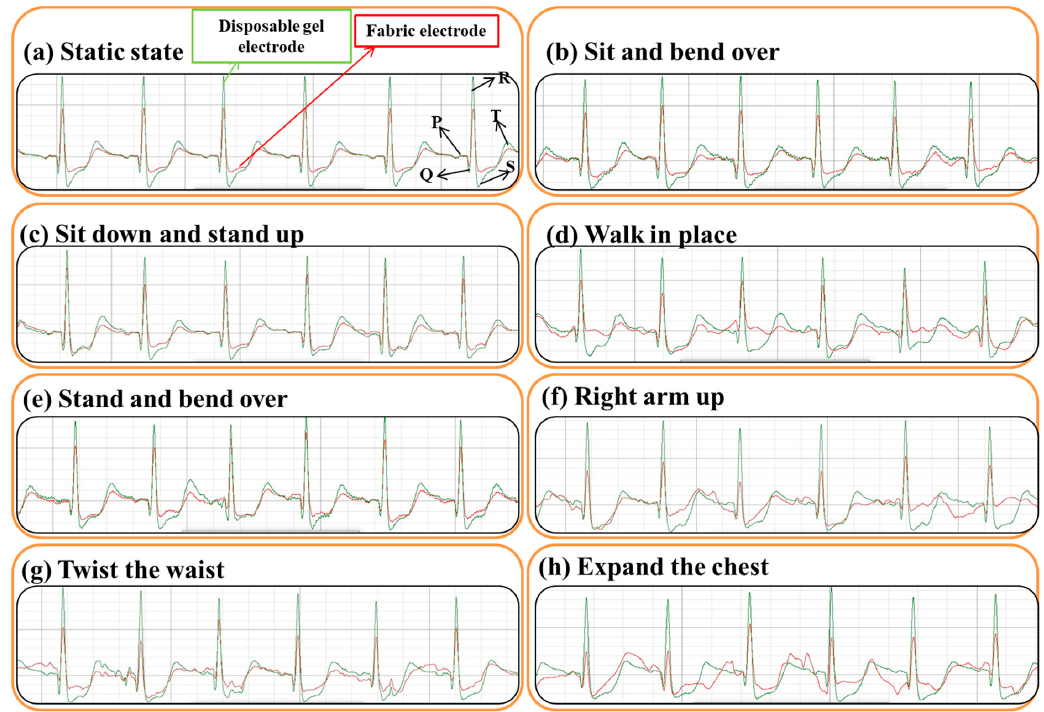
Figure 11. Highly hygroscopic knitted fabric electrodes and disposable gel electrodes monitor ECG in different states of the human body.